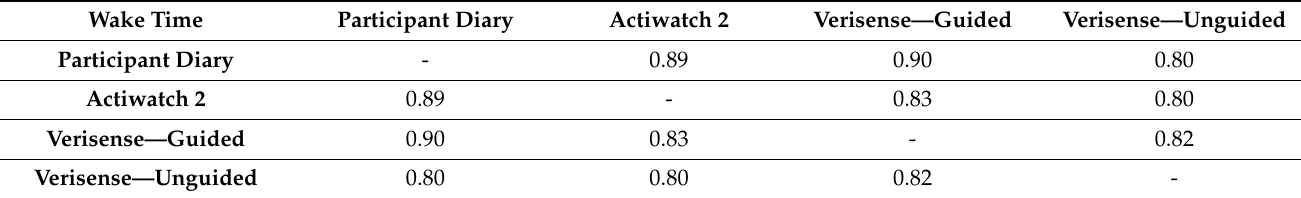
Table 4. Wake correlations. Table 5. TST correlations.